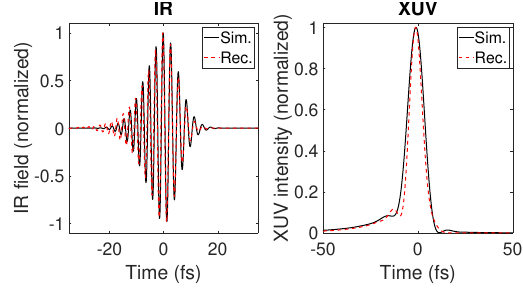
Figure 2. Result of the STRIPE reconstruction, applied to the trace simulated with SFA in Figure 1. The black solid lines show the simulated IR and XUV pulses, whereas the dashed red lines show the reconstructed